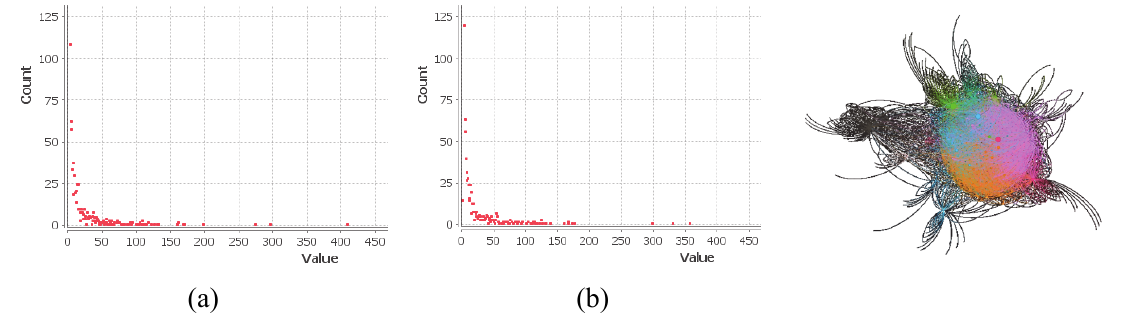
Fig. 2. Schematic of the generated network